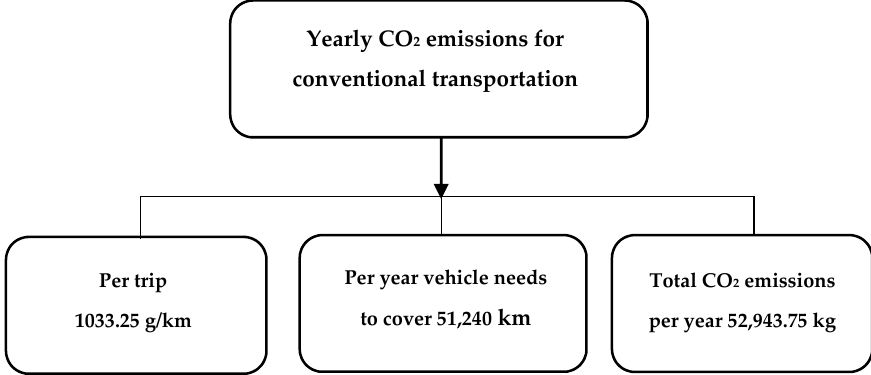
Figure 8. Yearly CO 2 emissions for the oil-based transportation system.